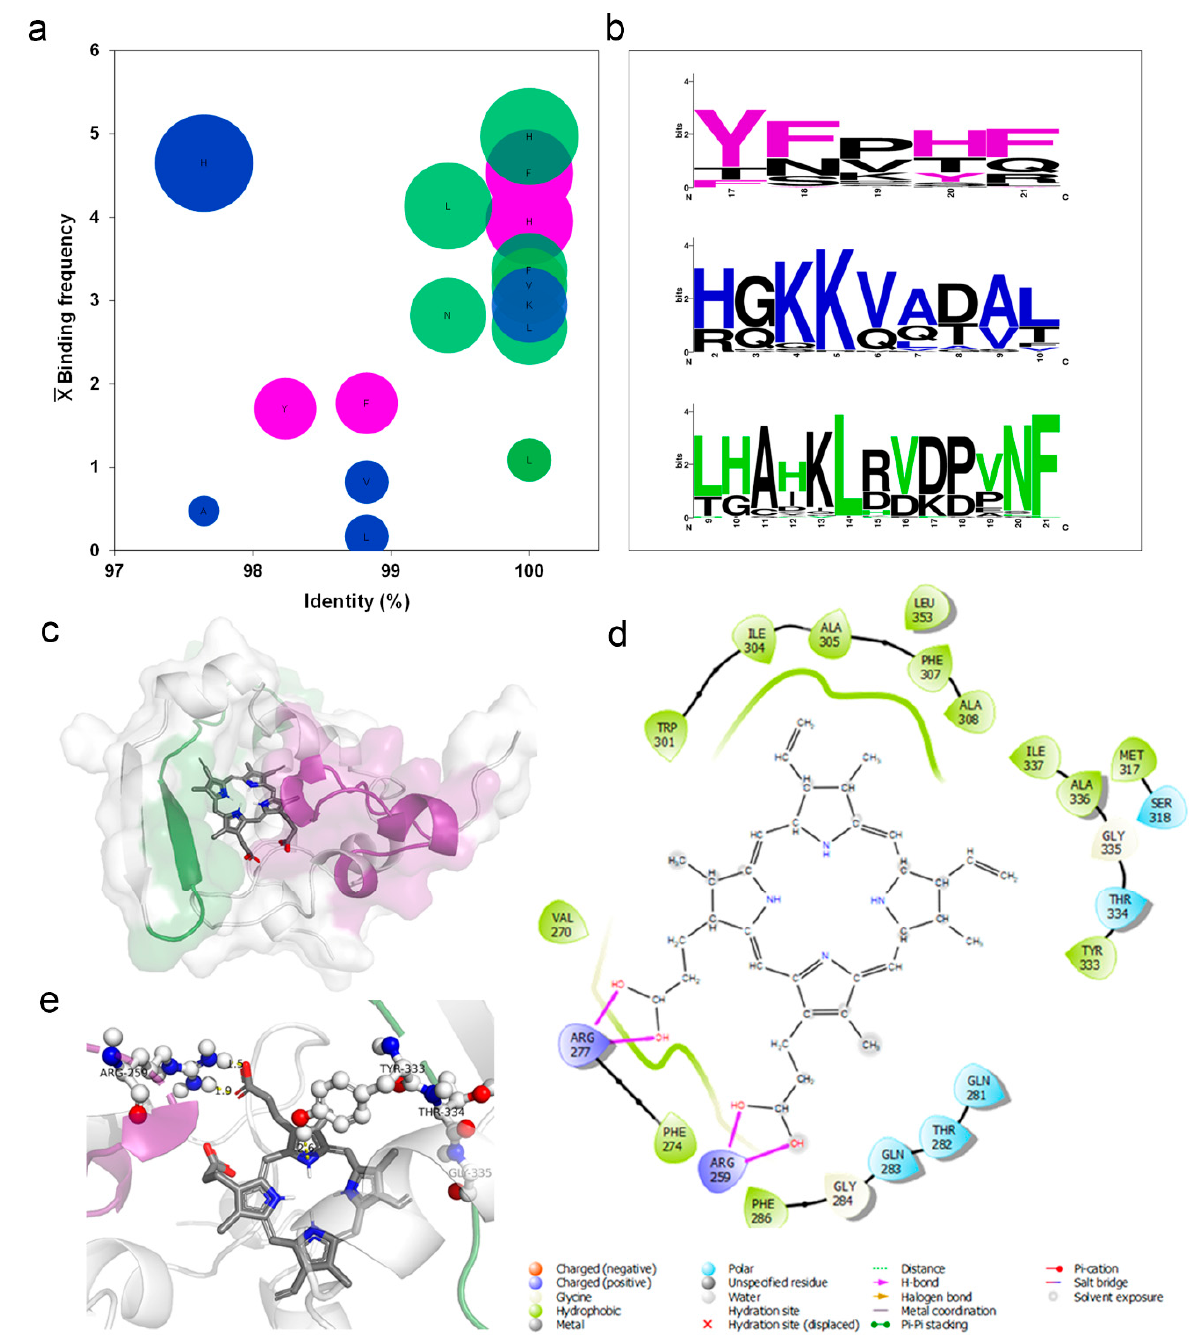
Figure 4. Heme-binding motifs were identified by an in silico analysis. ( a ) The heme-binding motifs for 68 Hb structures deposited in the PDB data bank were mapped to define the frequency of residues occurrence ( X Binding frequency) and degree of identity (%). The ball size is relative to the number of connections (5 to 1), displayed from biggest to smallest in size. ( b ) Three binding motifs were identified in the N protein of SARS-CoV-2 by an analysis in the MEME-Suite server of Hb amino acid sequence obtained from UniProt sever. Colored amino acids related to residues in Hb that interact with heme. Black residues form part of the motif without binding heme. The size of the amino acid relates to the number of occurrences (bits). Molecular docking of SARS CoV-2 N protein with human PpIX. ( c ) Binding position of PpIX (sticks) indicating the orientation of binding with N protein (surface) to predicted motifs: purple = motif one and green = motif 3. ( d ) Two-dimensional (2D) representation indicating types of bonds that occur in N protein pocket bounded with PpIX. ( e ) Three-dimensional (3D) model showing nucleoprotein amino acid residues (ball and sticks) that compose motifs 1 and 3 coordinating the binding with the PpIX (bars).